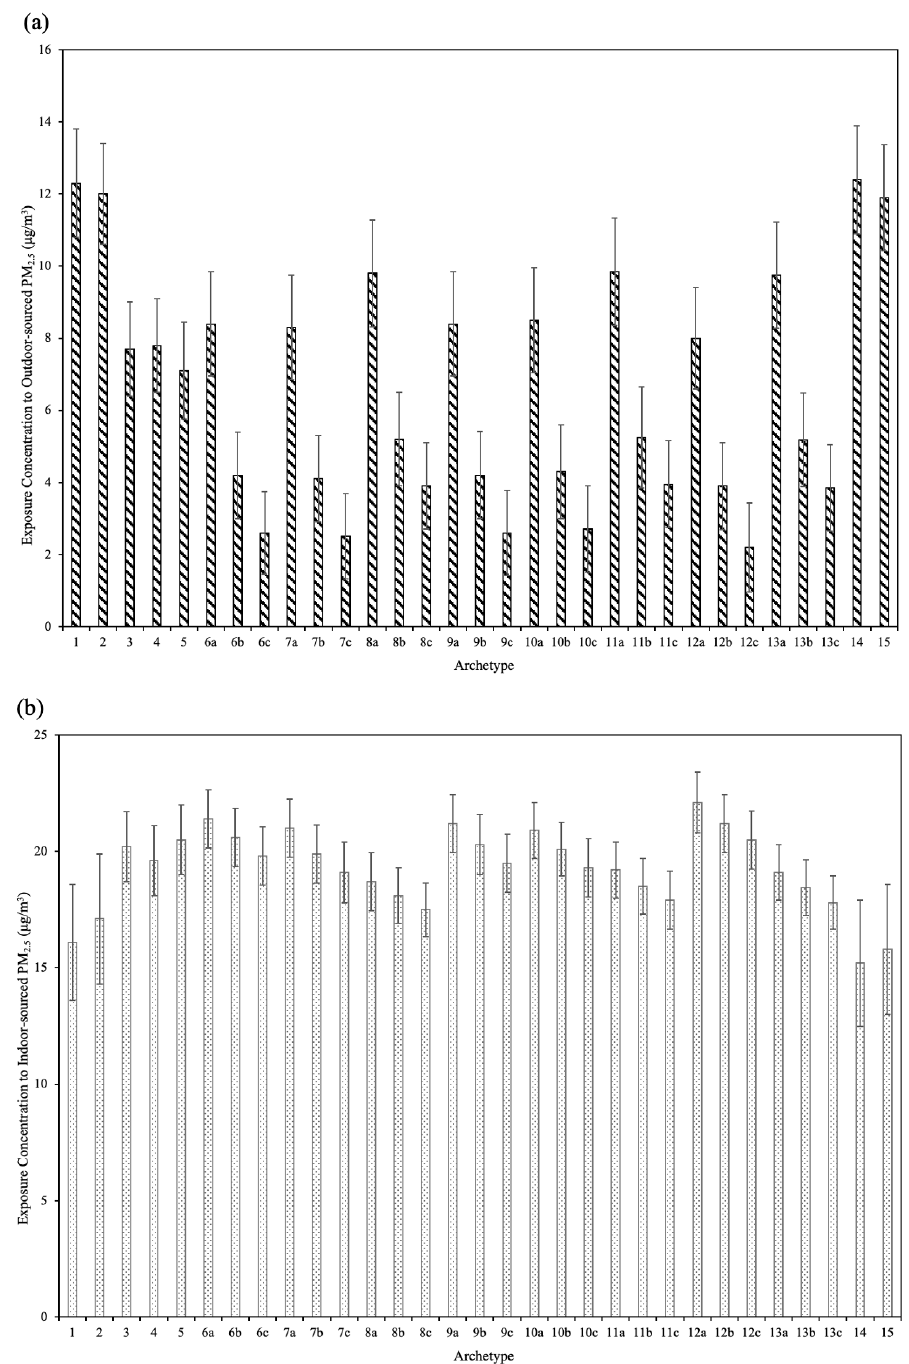
Figure 8. Annual average exposure concentrations to ( a ) outdoor-sourced PM 2.5 and ( b ) indoor- sourced PM 2.5 for individual archetypes (a: ground-floor flats, b: middle-floor flats, and c: top-floor flats), averaged over the pensioner and family results. The error bars indicate ±1 standard deviation.